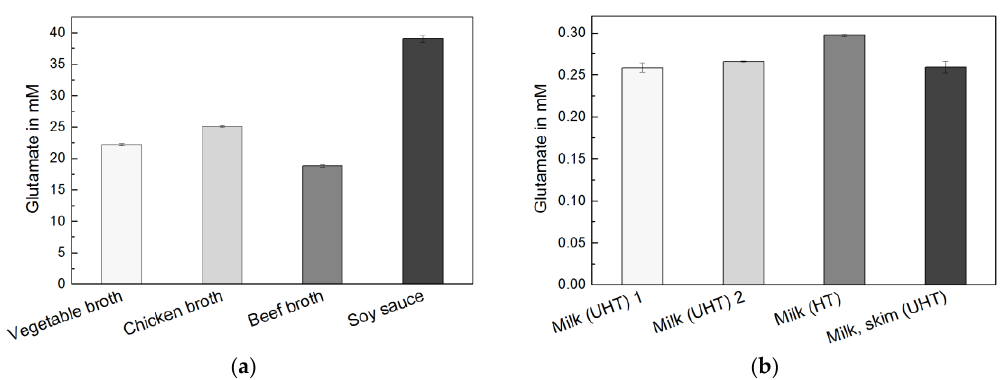
Figure 4. ( a ) Determined glutamate concentrations of foods with high glutamate content ( n = 3 each, average RSD = 1.1%); ( b ) Determined glutamate concentrations of different types of commercial (ultra-) high-temperature-treated (UHT) cow’s milk ( n = 3 each, average RSD =